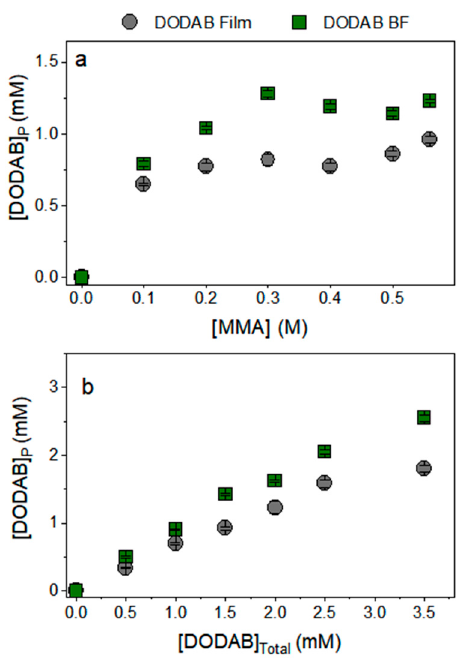
Figure 2. Incorporation of dioctadecyl dimethyl ammonium bromide (DODAB) in poly(methyl methacrylate) (PMMA)/DODAB nanoparticles (NPs) as a function of methyl methacrylate concentration ([MMA]) using 1.5 mM DODAB ( a ) and as a function of DODAB concentration employing 0.3 M MMA ( b ).